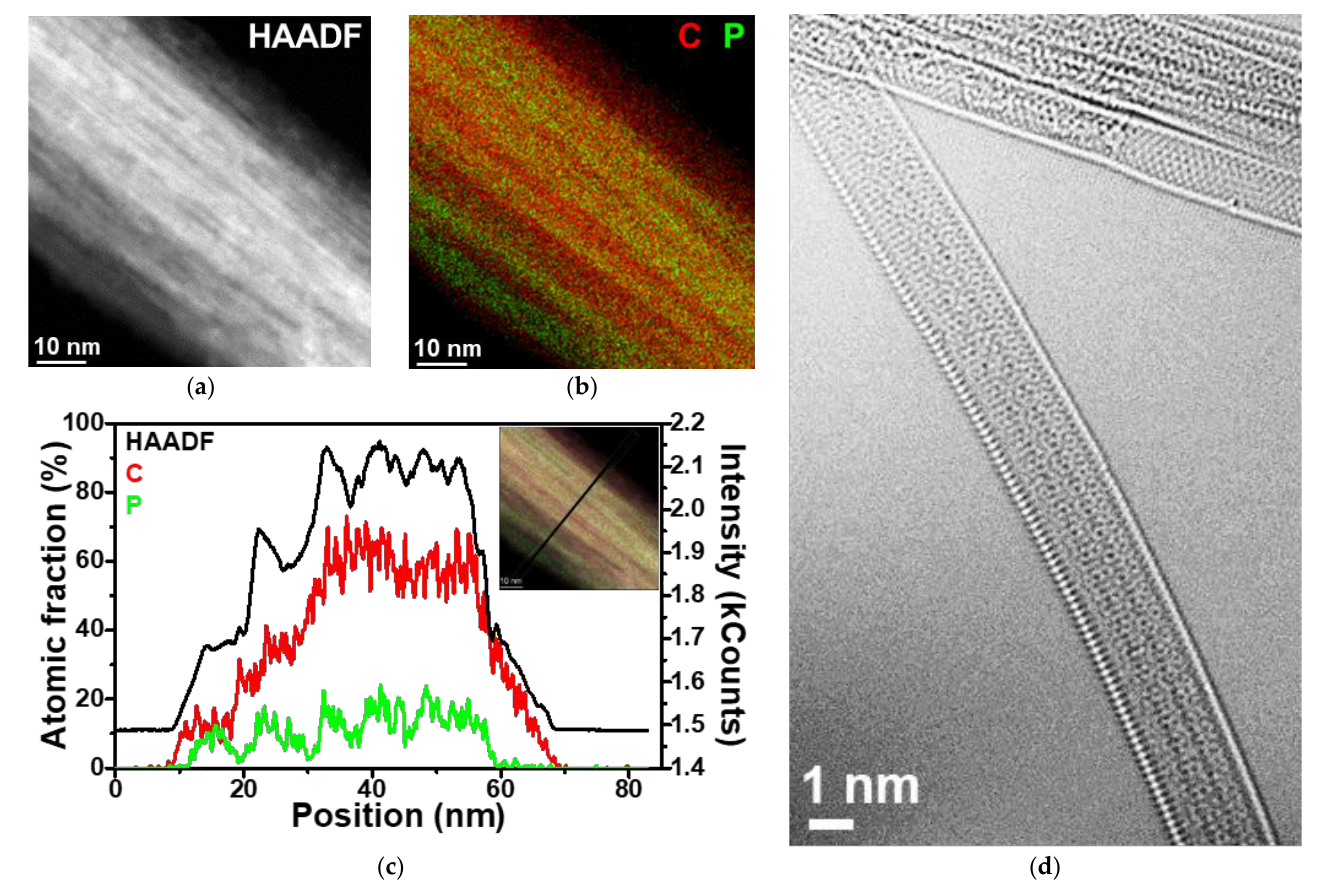
Figure 3. ( a ) HAADF image of P@SWCNTs; ( b ) corresponding EDS elemental map of carbon and phosphorus and ( c ) distribution of elements perpendicularly to the nanotube bundle (along the line shown in the inset); ( d ) HRTEM image of phosphorus-filled SWCNTs.